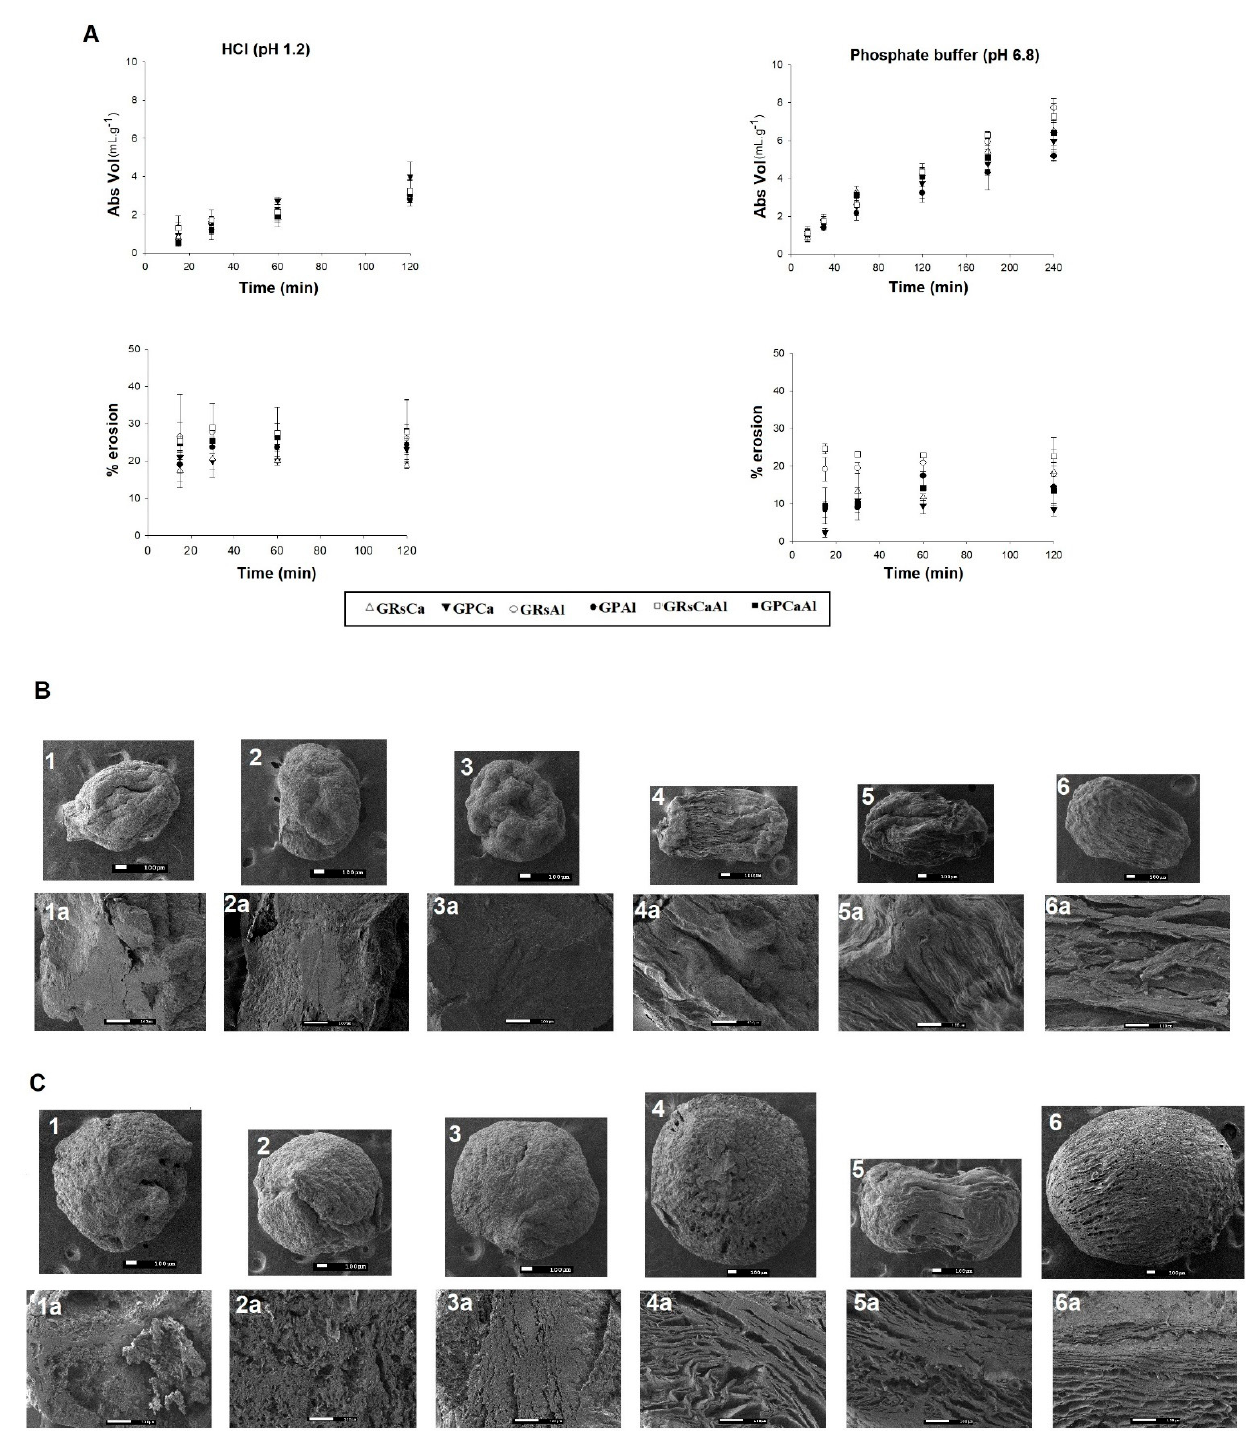
Figure 3. A - Samples profiles of liquid uptake and erosion; B -Photomicrographs of PMs after incubation (120 min) in HCl (pH 1.2); C - Photomicrographs of PMs after incubation (120 min) in phosphate buffer (pH 6.8). (1: GRSCa 40 × ; 1a: GRSCa 150 × , 2: GRSAl 40 × ; 2a: GRSAl 150 × , 3: GRSCaAl 40 × ; 3a: GRSCaAl 150 × , 4: GPCa 40 × ; 4a: GPCa 150 × , 5: GPAl 40 × ; 5a: GPAl 150 × . 6: GPCaAl 40 × ; 6a: GPCaAl 150 × ). The same behavior was observed for particles composed by GG:P. After 15 min of testing, the GPCa particle had absorbed 0.95 mL.g − 1 of the medium, value higher than that observed for GPAl and GPCaAL, which absorbed 0.75 and 0.54 mL.g − 1 , respectively.